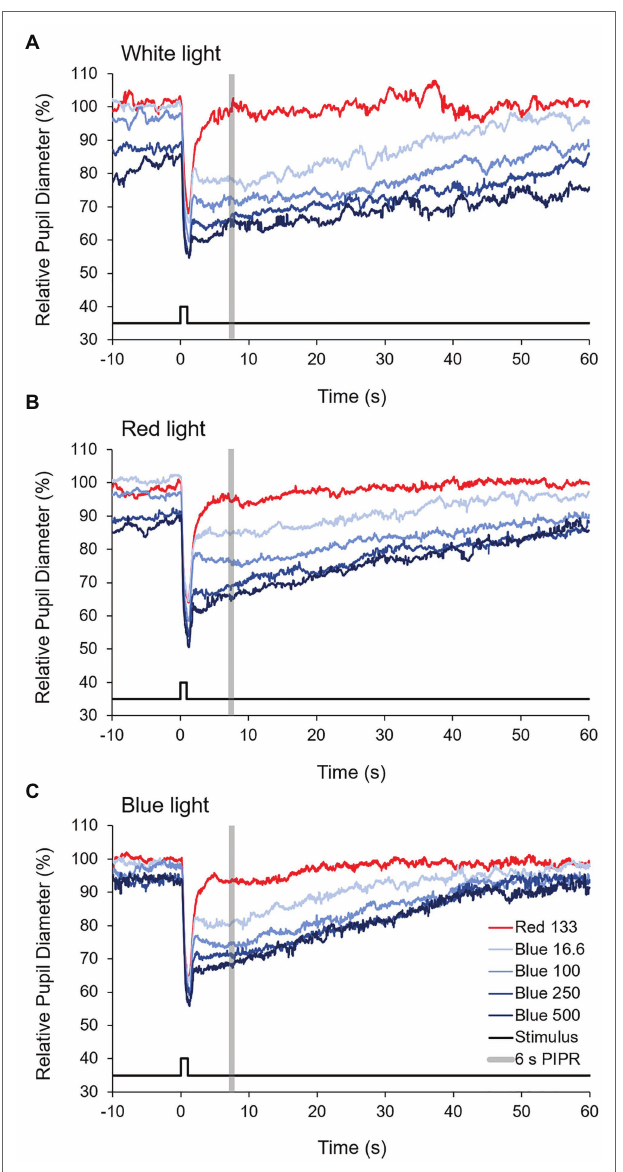
FIGURE 5 | Averaged pupil traces to 1 s red (133 cd/m 2 ) and four increasing intensities of blue (16.6, 100, 250, and 500 cd/m 2 ) stimuli for (A) white light, (B) red light, and (C) blue light reared